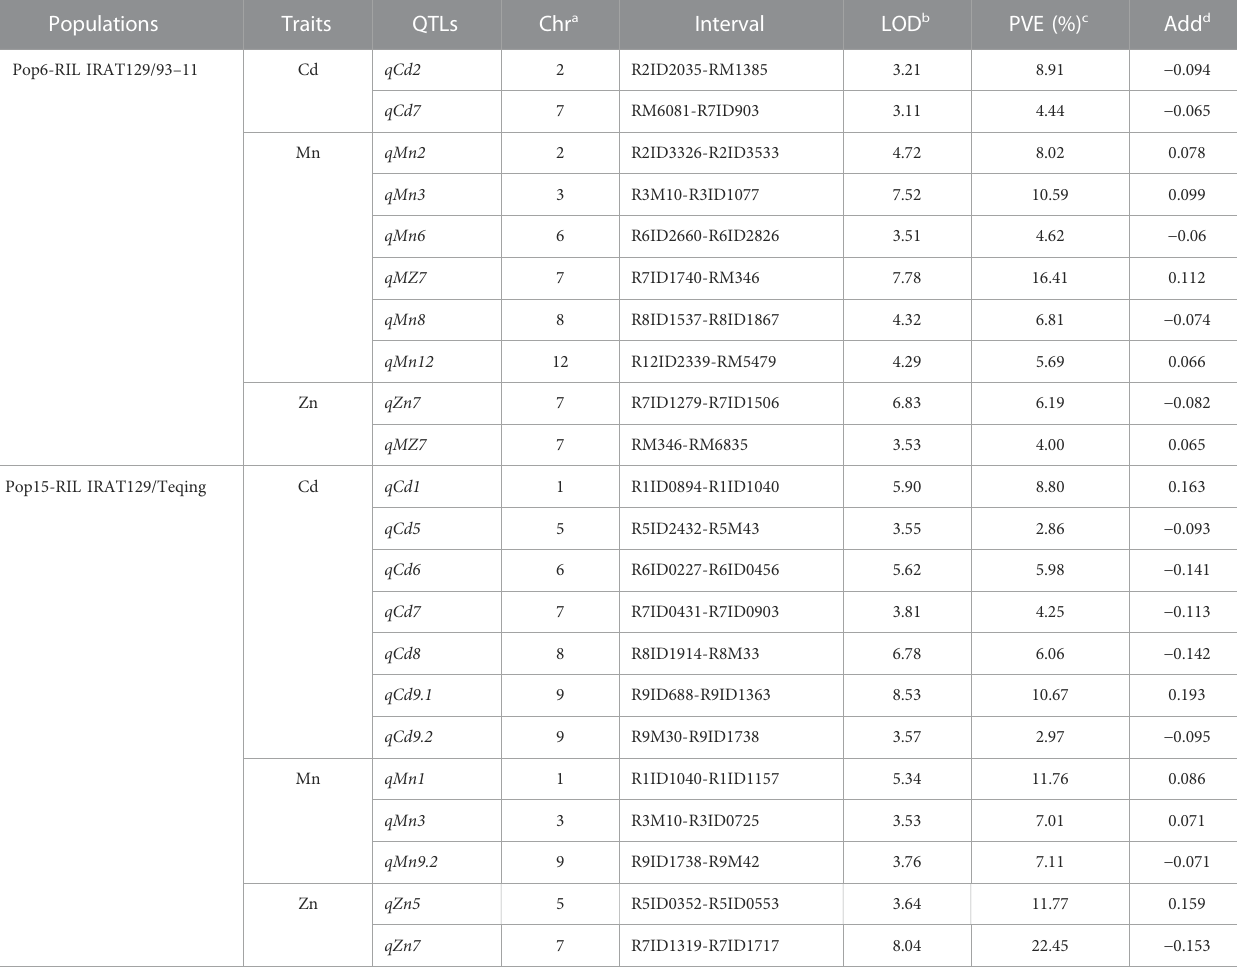
TABLE 2 QTLs responsible for comparative mineral accumulation (CCd, CMn, and CZn) in the grains of the two RIL populations. Populations Traits QTLs